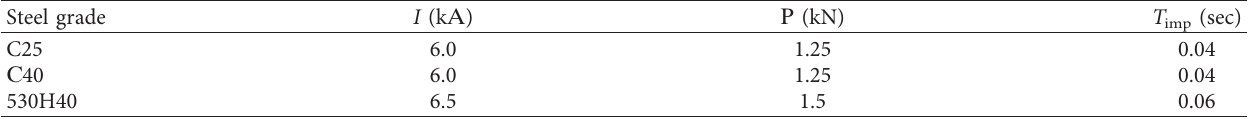
Table 2: Modes of electrocontact surfacing of samples from different steel grades.